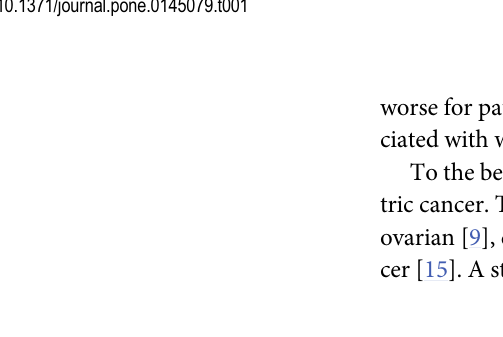
Abbreviations: HPA2110 = polyclonal antibody, HES9 = monoclonal